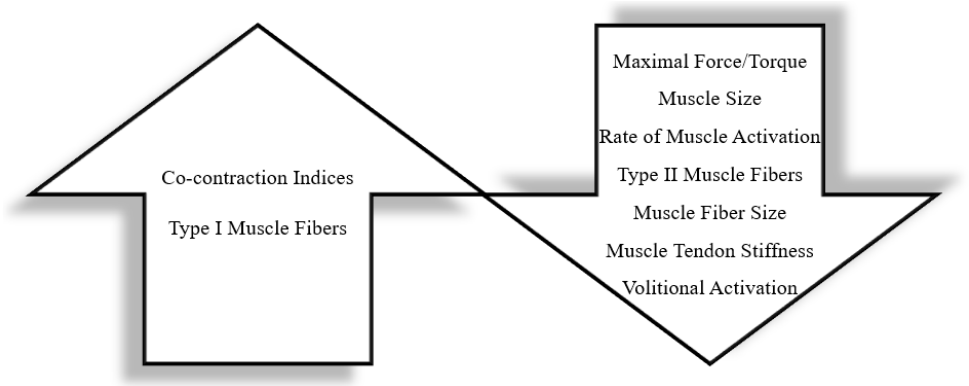
Figure 3. Expected Child – Adult Differences in Skeletal Muscle. The upward arrow includes elements of skeletal muscle that are expected to be increased in children compared to adults. The downward arrow includes elements of skeletal muscle that are expected to be decreased in children compared to adults.